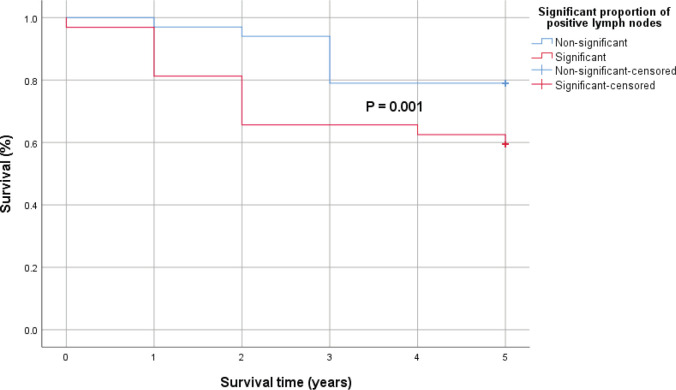
Kaplan–Meier survival curve comparing the 5-year survival of patients with significant proportion of positive lymph nodes (red) and those without (blue) with 0.001 p-value by log-rank test.